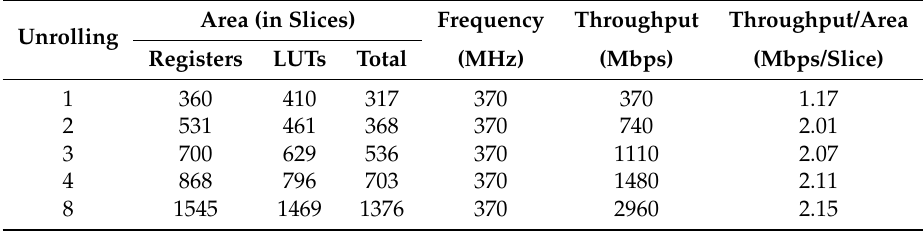
Table 5. MICKEY-128 2.0 synthesis results (Xilinx Spartan6, device